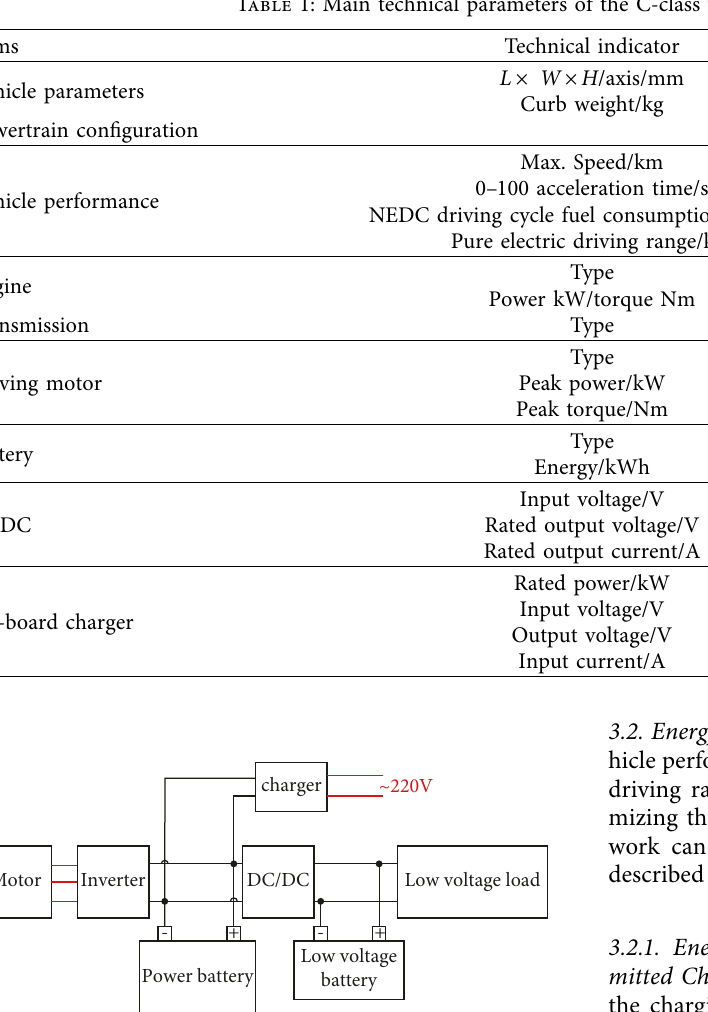
Figure 2: High-voltage system